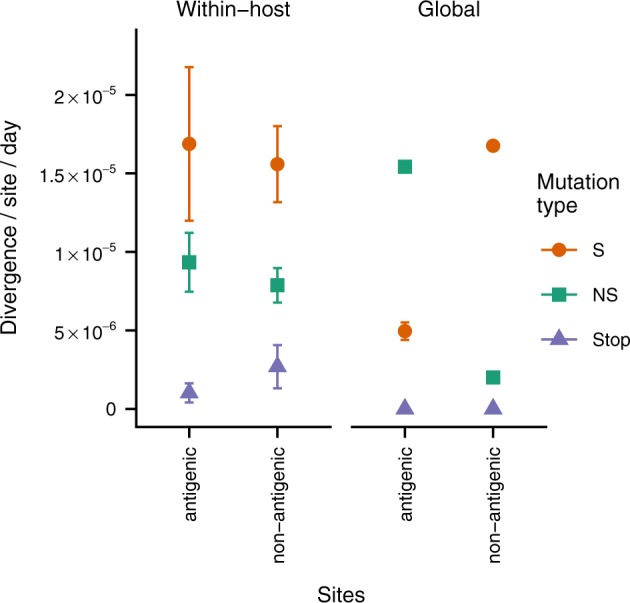
Antigenic and non-antigenic regions of hemagglutinin show similar patterns of variation within hosts, but antigenic regions evolve faster at the global scale. Within-host and global evolutionary rates were calculated as described in Fig. 3 for a set of previously defined antigenic sites (Wolf et al. 2006). Within-host rates are shown as the mean and standard error of all patient infections sequenced in the three datasets analyzed after removing outlier samples (see Section 4) (Dinis et al. 2016; Debbink et al. 2017; McCrone et al. 2018). Global rates are shown as the mean and standard error calculated through linear regression (in most cases, the standard errors are smaller than the point sizes). Global rates of stop-codon evolution are zero because no stop codons are observed in patient consensus sequences.